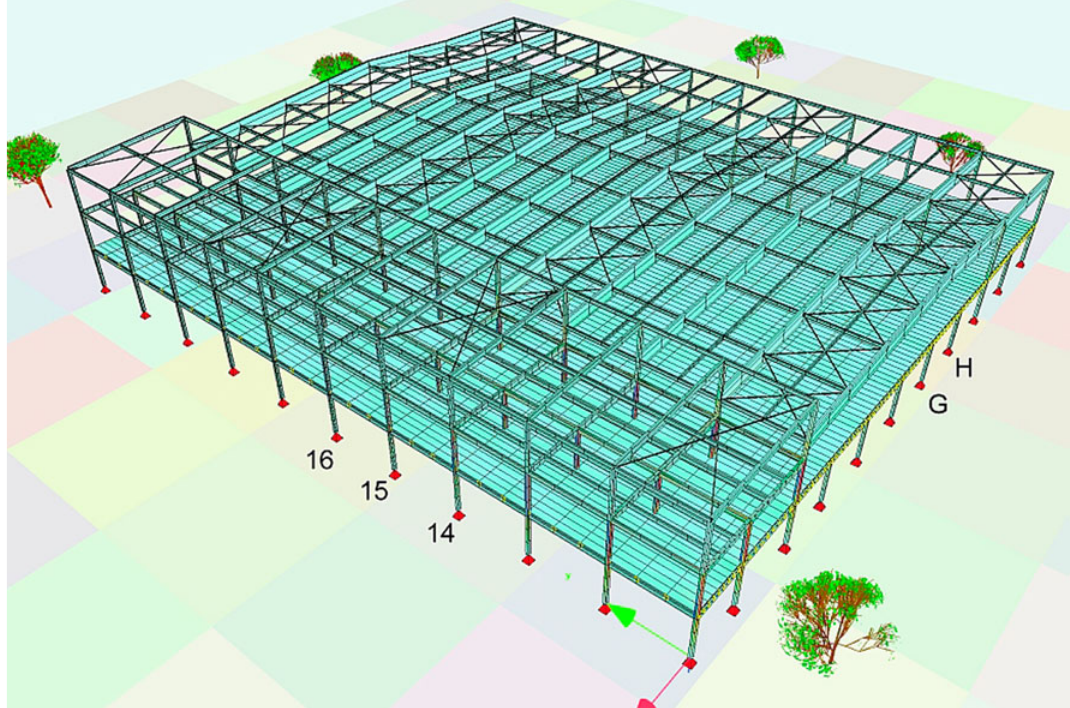
Fig. 9. General computer model of the industrial